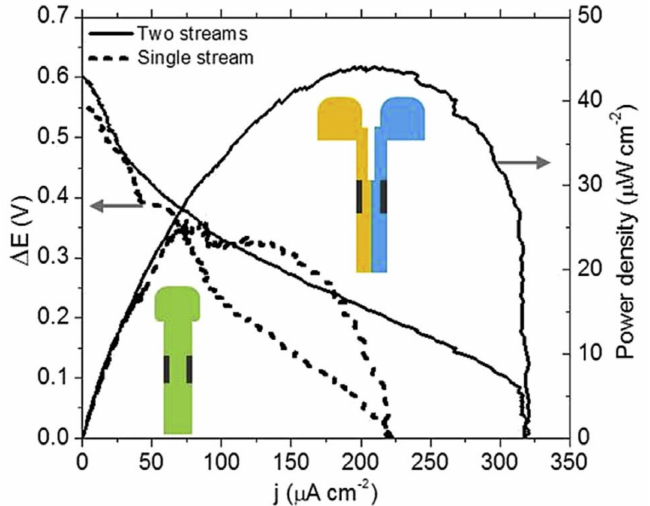
Figure 10. Polarization and power curves of two enzymatic paper-based fuel cells: single stream I-shaped (dotted lines) and two streams Y-shaped (solid lines) configurations. Reprinted from [40], with permission from